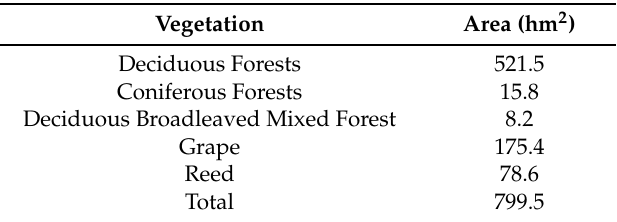
Table 2. The forest resource distribution of Lakeside Wetland